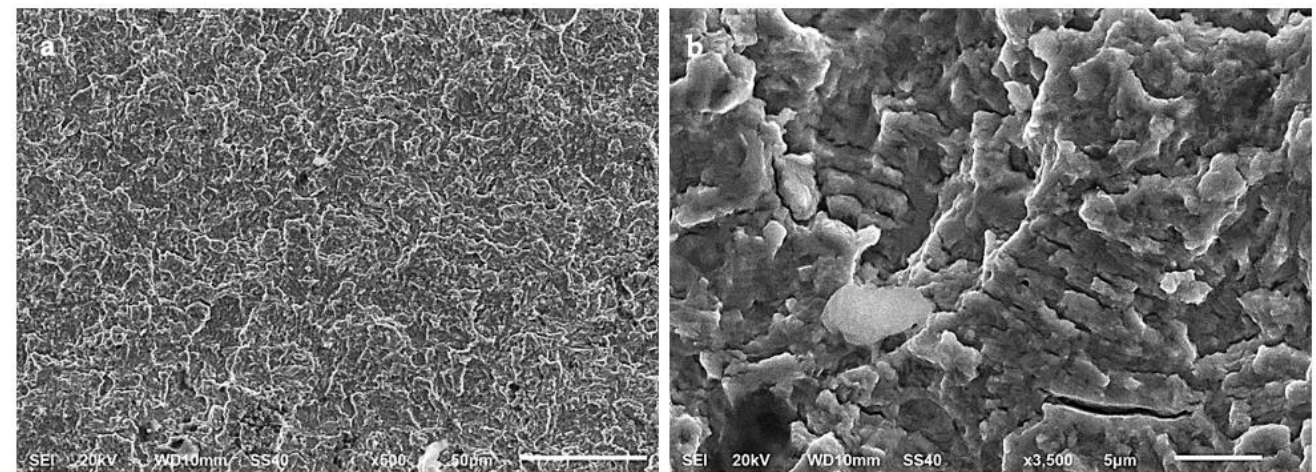
Figure 14. Crack propagation area of an A-type steel specimen tested in air to a maximum stress of 1160 MPa (81% YS) at ( a ) ×500 ( b ) ×3500.